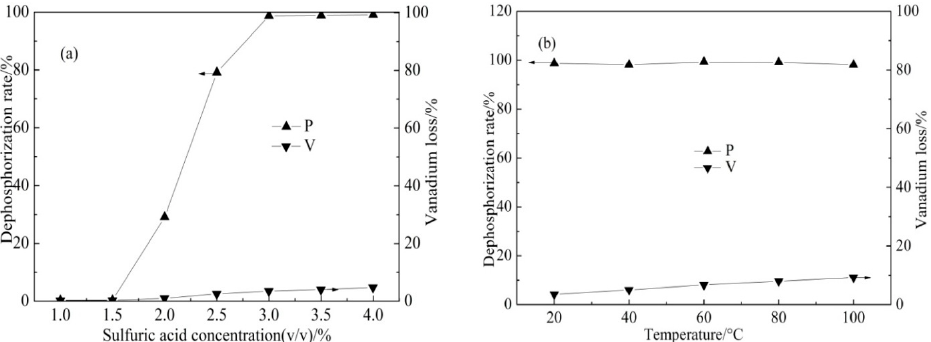
Figure 4. Effects of sulfuric acid concentration ( a ); and temperature ( b ) on the dephosphorization rate and the vanadium loss rate.